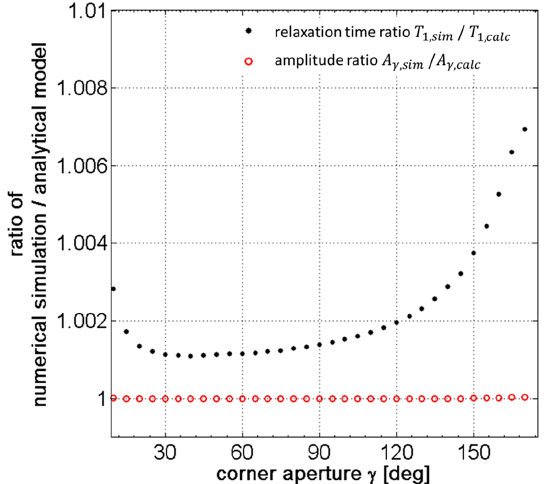
Figure 11. Comparison of analytical and calculated NMR relaxom- etry data originating from saturated pore corners (e.g., see Fig. 7) of varying apertures (5 ◦ <γ < 175 ◦ ) and an equal active surface- P γi = const (NMR model parameters: T to-volume ratio A γi